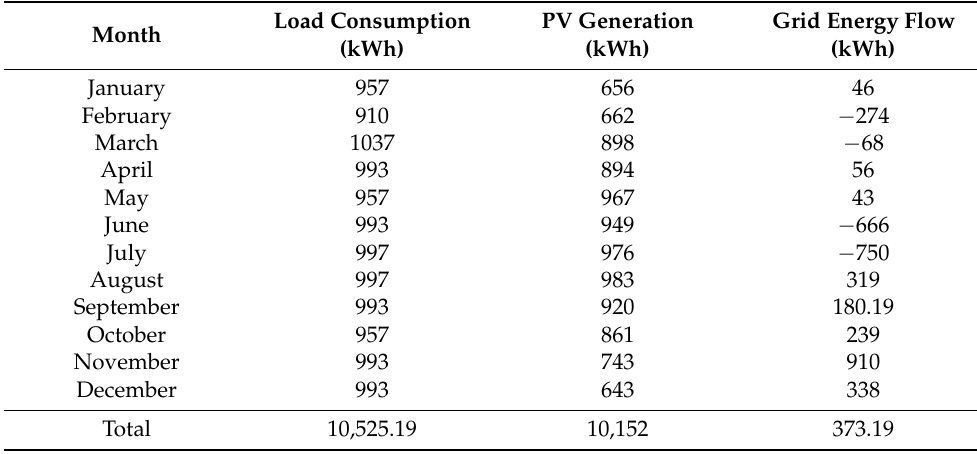
Table 7. Energy flow analysis for the 5.18 kWp grid-connected